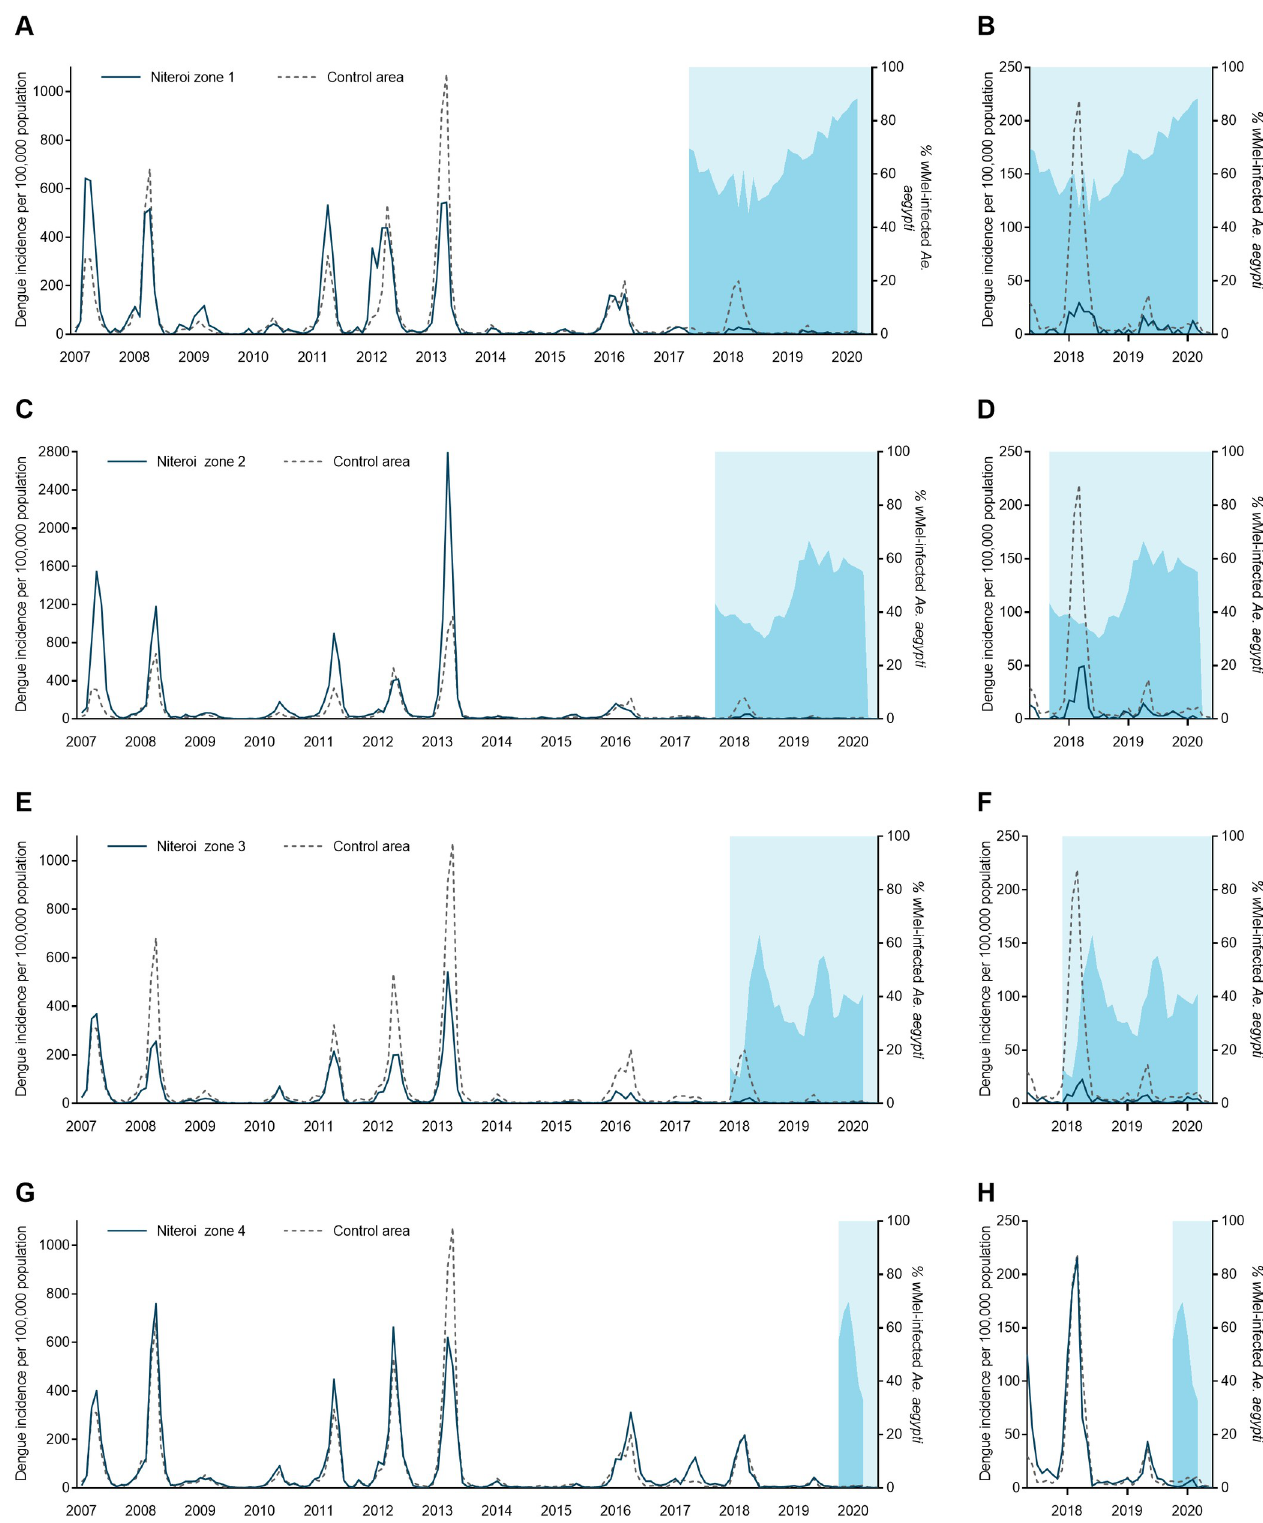
Fig 4. Dengue incidence and w Mel infection prevalence in local Aedes aegypti mosquito populations, by release zone. Panels A,C,E,G: Lines show the monthly incidence of dengue case notifications per 100,000 population (left-hand Y axis) in Nitero´i release zones 1–4 (solid line in each panel) compared